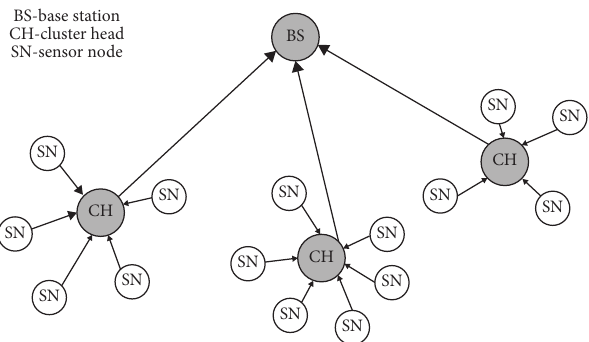
Figure 3: Schematic diagram of LEACH protocol topology.